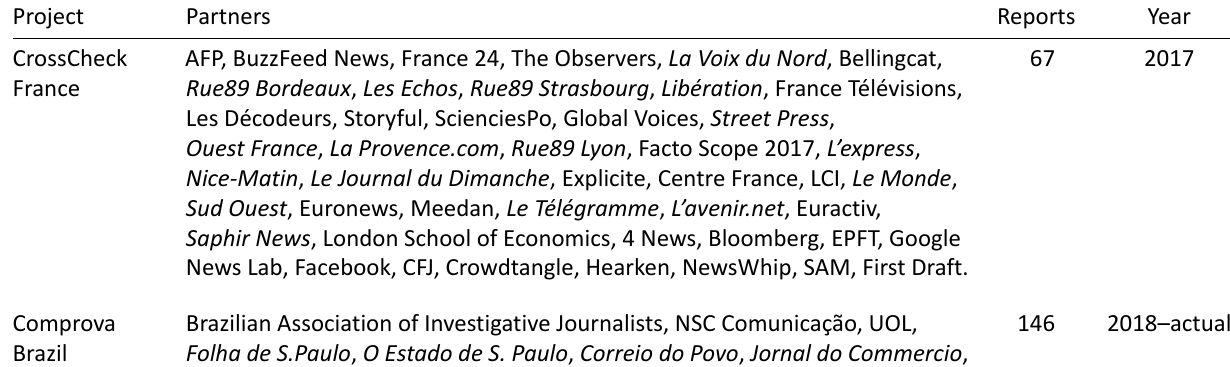
Table 1. List of First Draft election cross-checking projects